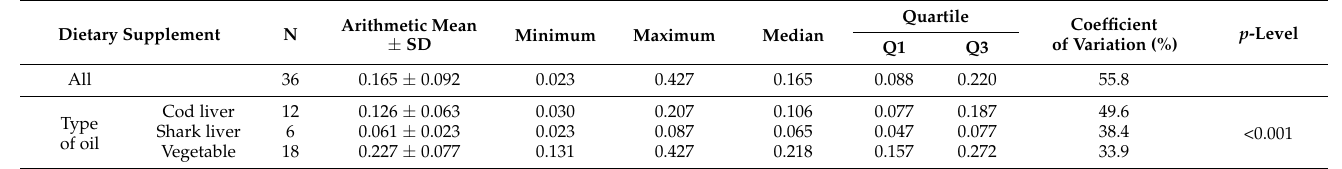
Table 2. Hg concentrations in the tested dietary supplements ( µ g/kg).